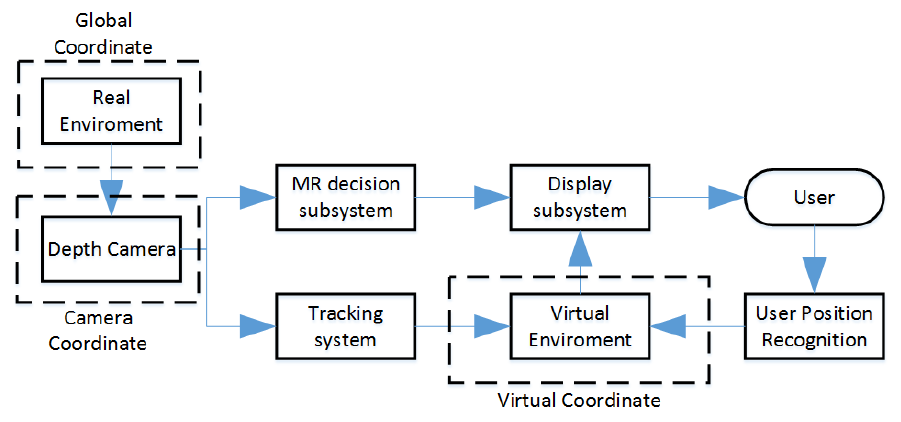
Figure 7. Information flow in MR measurement and display